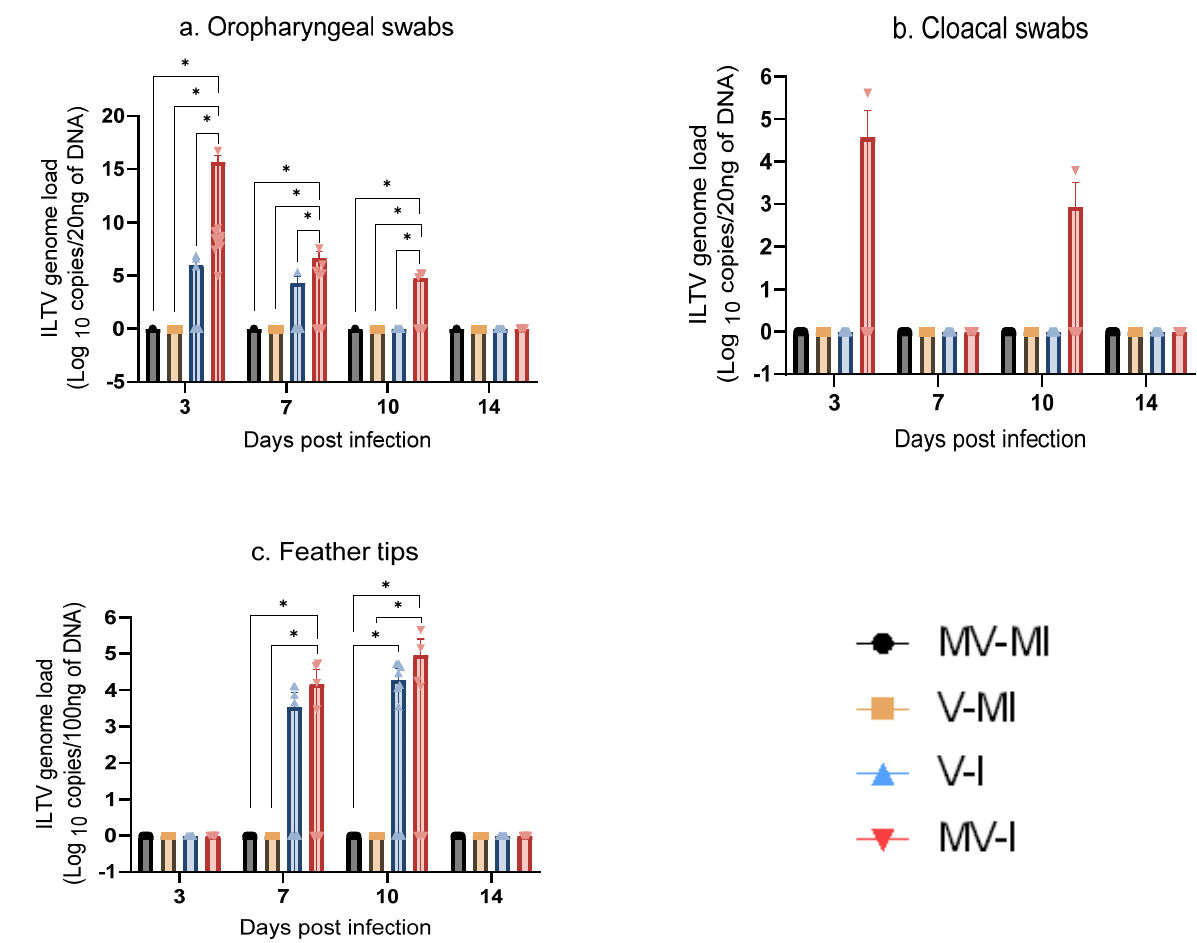
Figure 5. ILTV genome loads quantified targeting the PK gene at 3, 7, 10 and 14 days post-infection (dpi). The bars represent the mean, and error bars indicate the standard error of mean (SEM). Kruskal–Wallis test followed by Dunn’s multiple comparison test was used to identify group differences. ( a ) ILTV genome loads in oropharyngeal swabs; ( b ) ILTV genome loads in cloacal swabs; ( c ) ILTV genome loads in feather tips. * = p < 0.05.